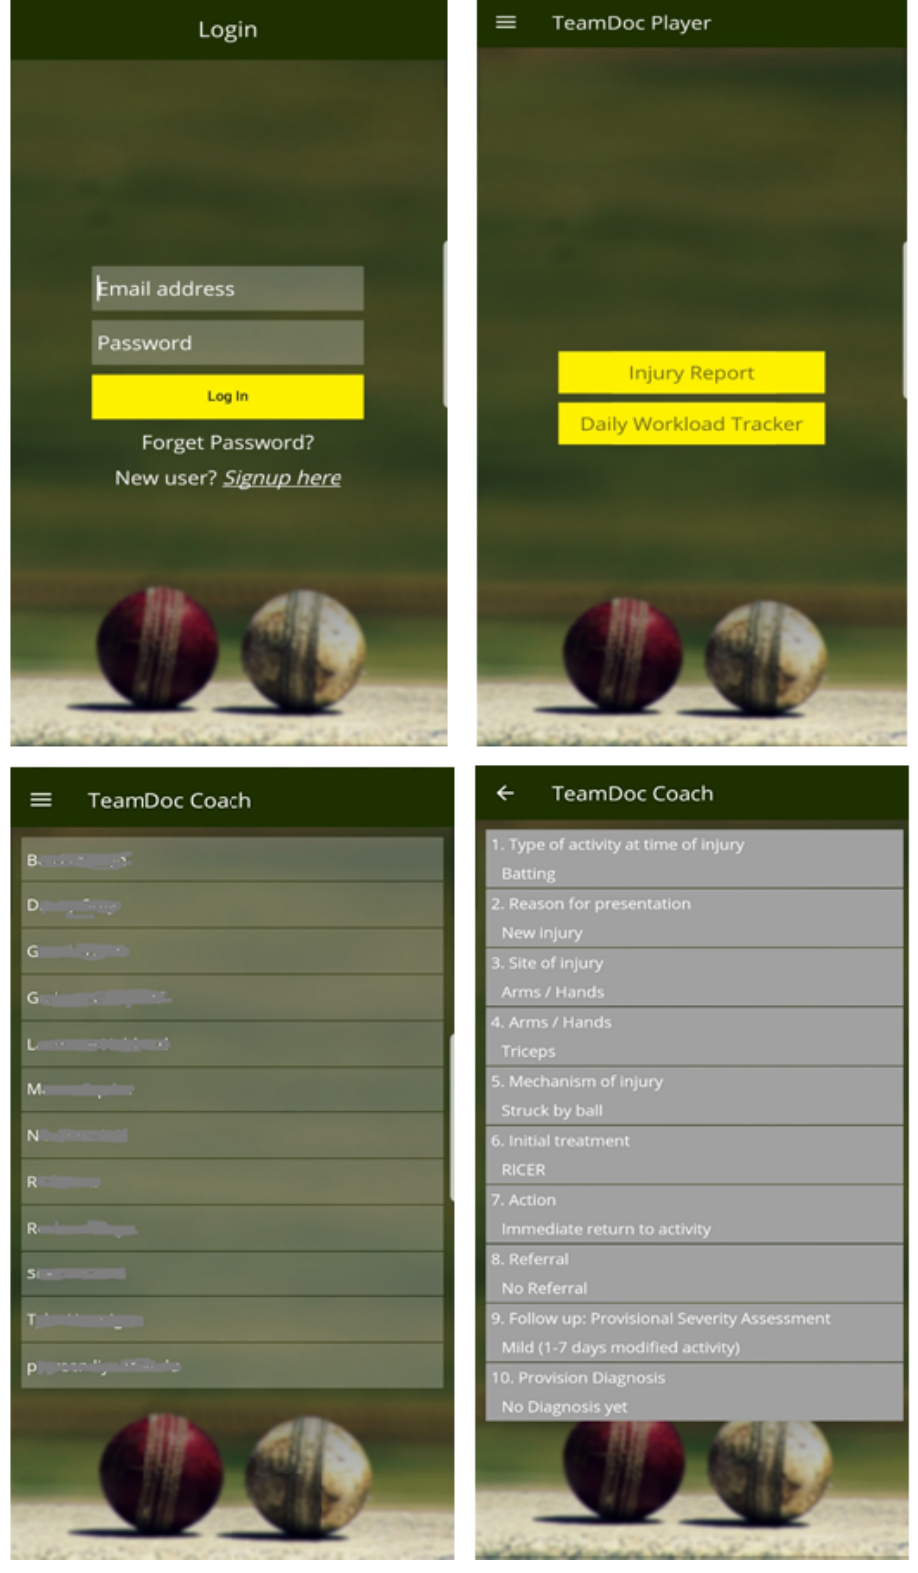
Figure 3. User interface of the TeamDoc app. Top left: log-in view; top right: main tab of the player app; bottom left: main tab of the coach app; bottom right: injury report tab in the coach